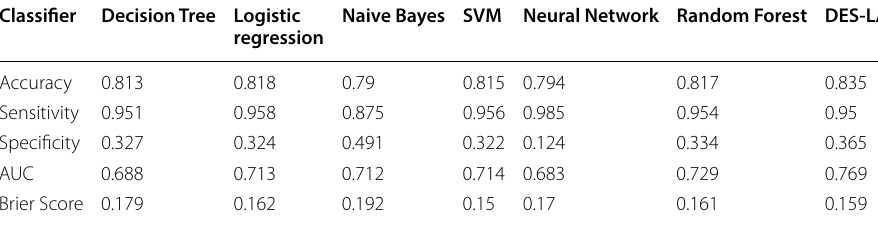
Table 7 Classifier performance with filtering on large default payments dataset Classifier Decision Tree Logistic Naive Bayes SVM Neural Network Random Forest regression